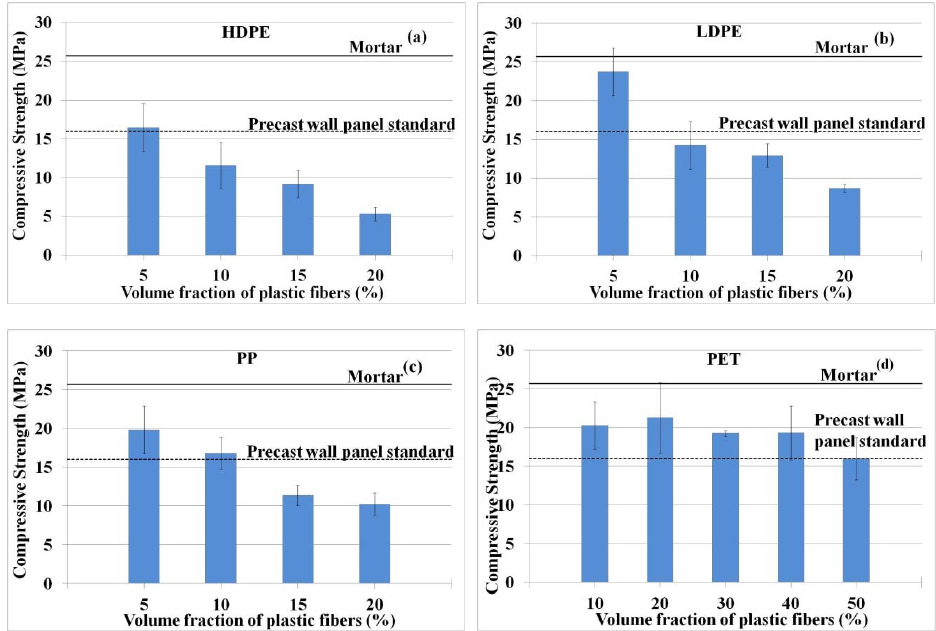
Figure 8. Compressive strengths of produced concrete; ( a ) HDPE, ( b ) LDPE, ( c ) PP, and ( d ) PET fibers. The compressive strength of mortar (control sample) and the standard of compressive strength for precast concrete wall panel are denoted with solid lines and dash lines, respectively.